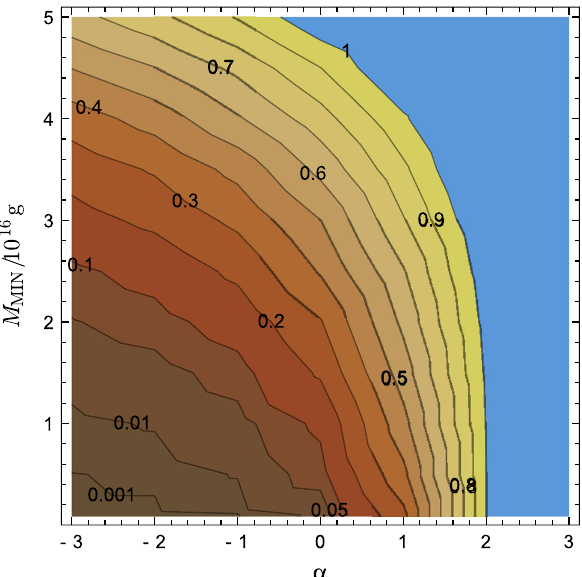
Fig. 9 Relative contribution of PBH with M ∼ 10 16 g and power-law mass distribution into DM in dependence on degree of the power-law α and lower cut in mass M min (see (25))